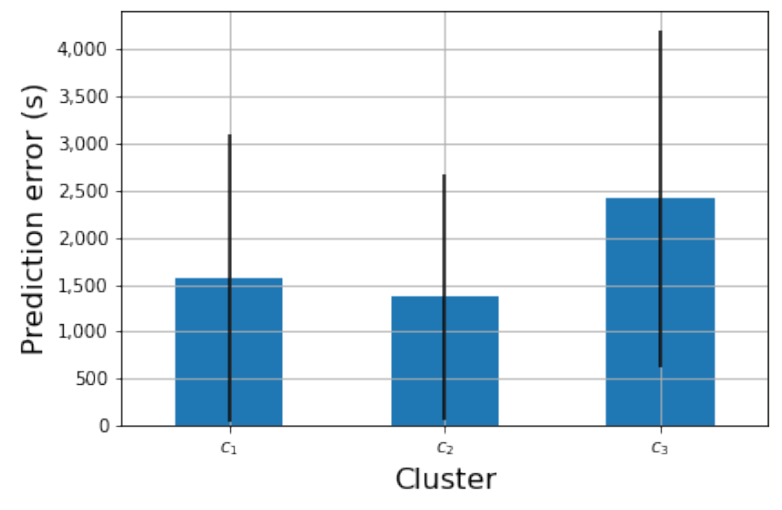
Figure 9. Residual error of the prediction mechanism given the identified